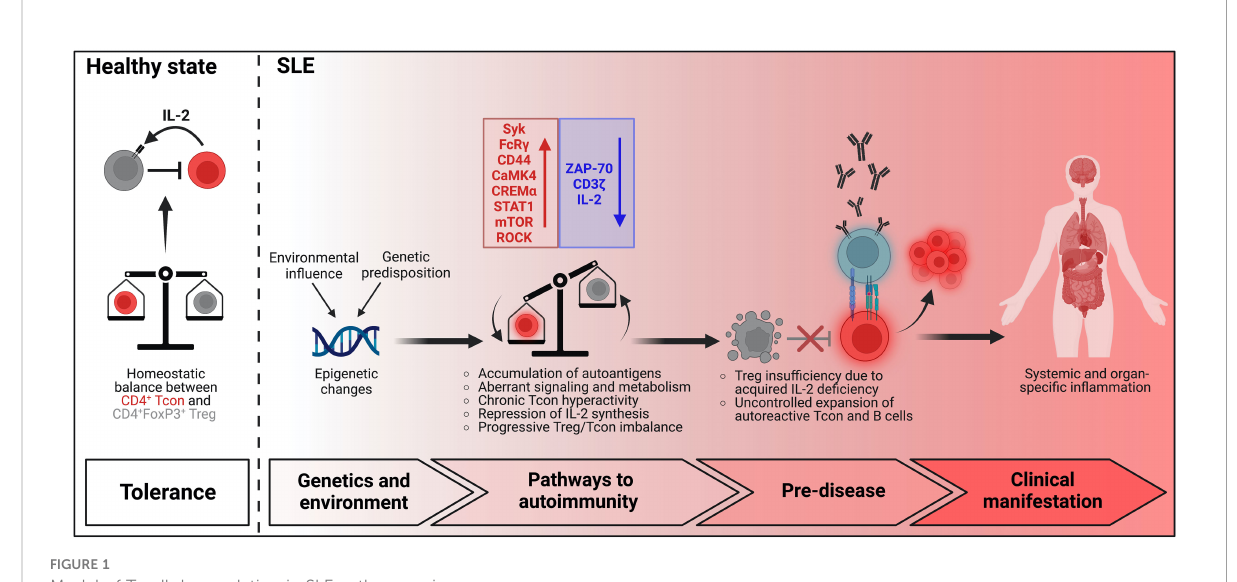
FIGURE 1 Model of T cell dysregulation in SLE